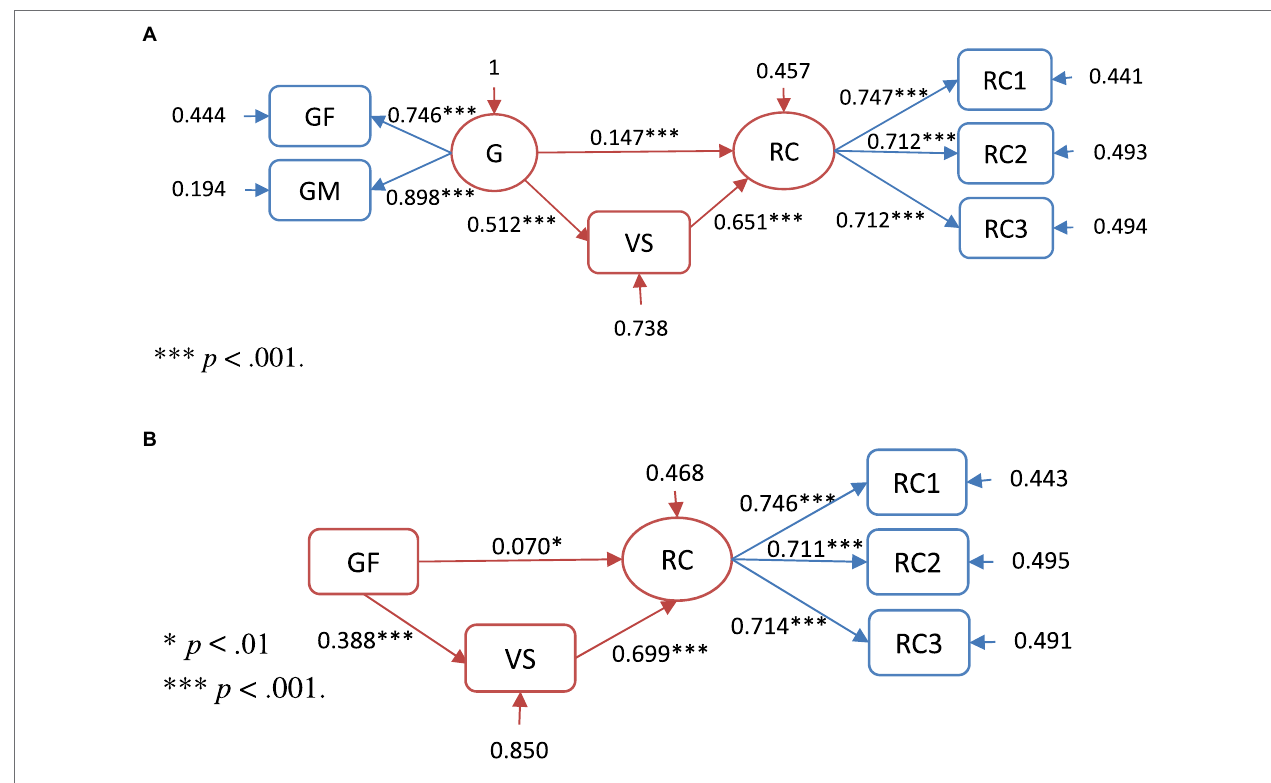
FIGURE 3 | (A) Visualization of the structural model with standardized direct effects. *** p < 0.001. (B) Visualization of the structural model with the standardized direct effects of the GF model. * p < 0.01 and *** p <